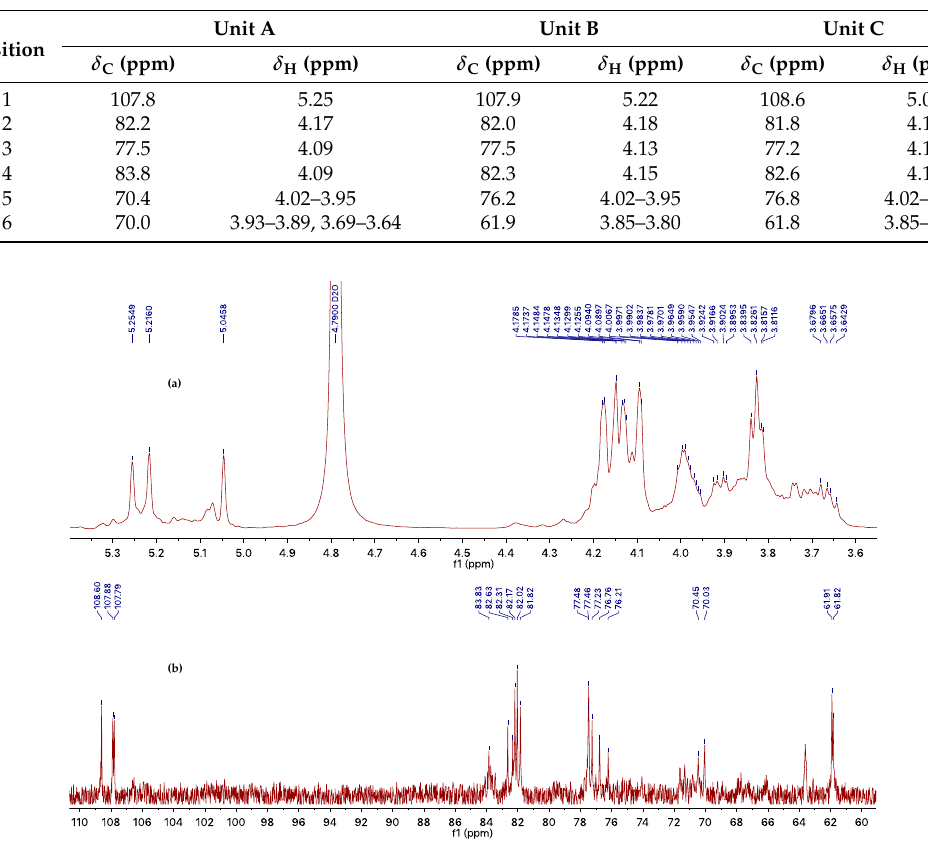
Table 2. 1 H- and 13 C-NMR chemical shifts for the impure galactan from Phomopsis sp. FJBR-11. Position